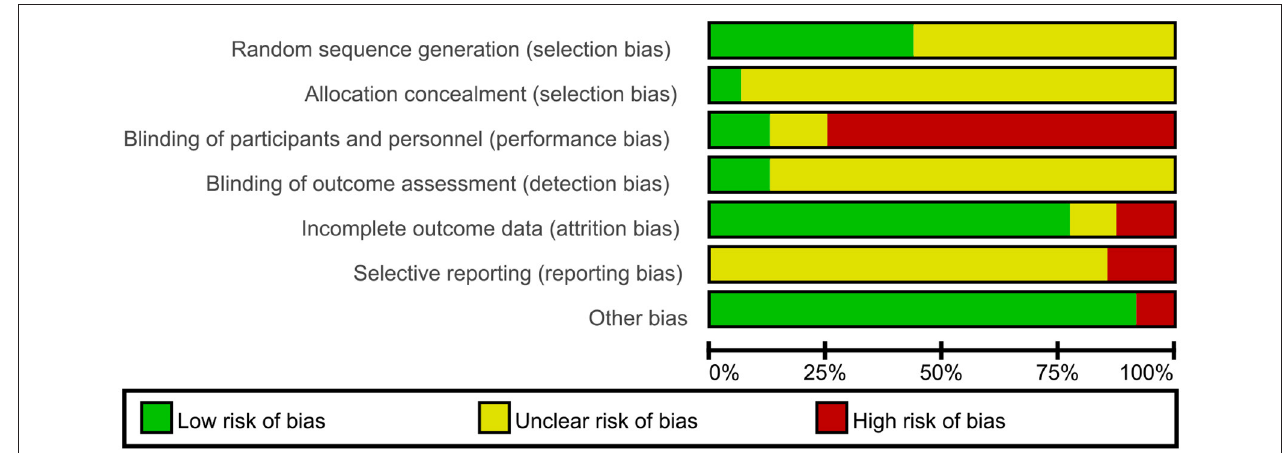
FIGURE 2 | Risk of bias graph: review authors’ judgments about each risk of bias item presented as percentages across all included